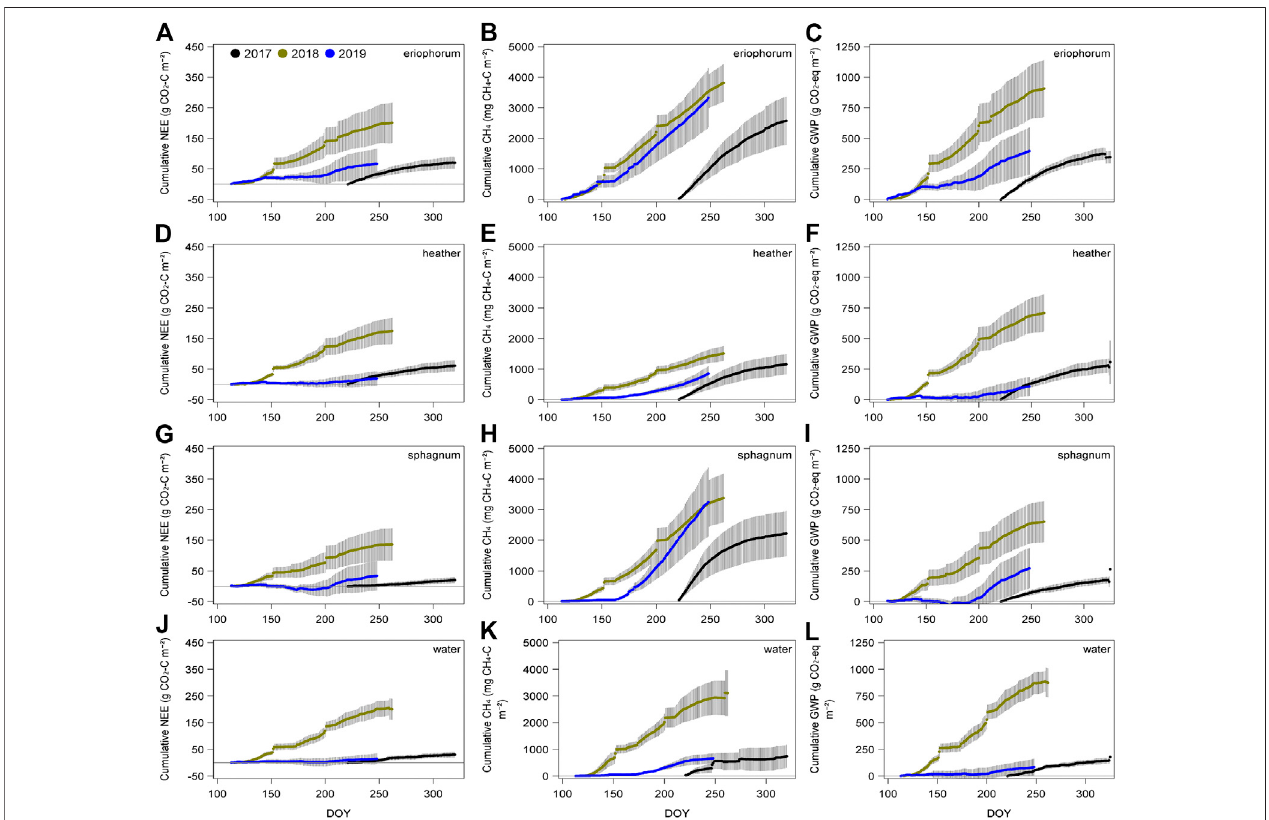
FIGURE 4 | Mean daily cumulative fl uxes of CO2 (A,D,G,J) , CH4 (B,E,H,K) and aggregated CO2 and CH4 in terms of global warming potential (IPCC, 2013, C,F,I,L ) for each ecotype (n 6, ± 1 SE) for 2017 (black line), 2018 (olive line) and 2019 (blue line).